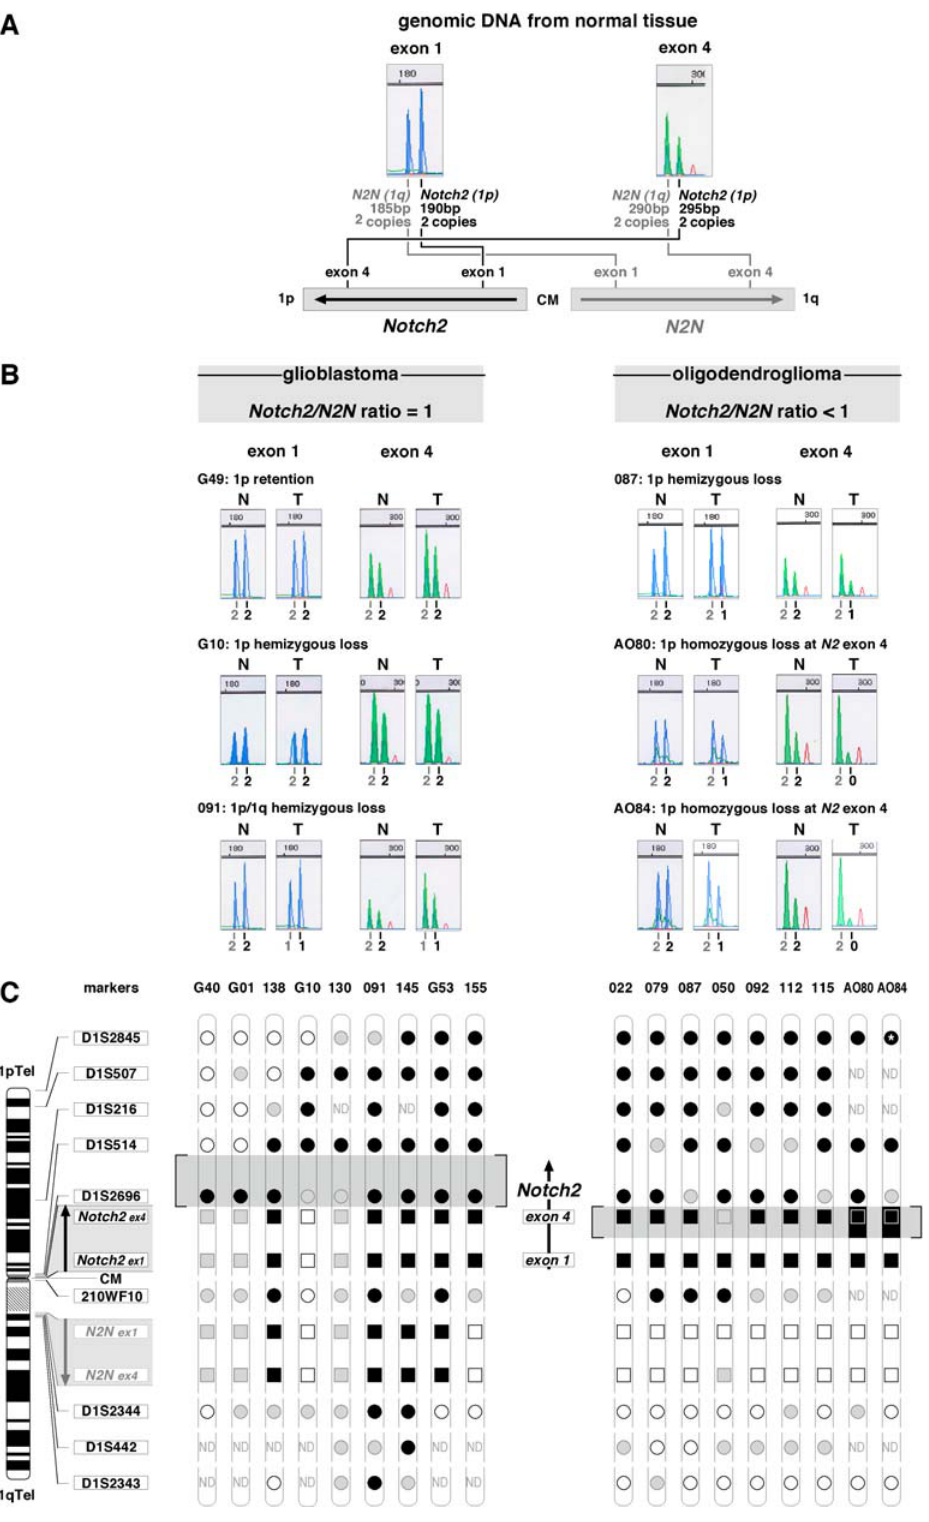
Figure 3. Refined somatic 1p deletion mapping in OD and GBM converge totheNOTCH2gene. (A) Schematic drawingof thechromosome 1 pericentric duplication and principle of the PCR-based N2/N2N test. NOTCH2 markers are in black and N2N markers are in grey. (B) The N2/N2N test distinguishes GBM (left) from OD (right). Electrophoretograms of GBM with (G10 and 091) or without (G49) 1p loss always show N2/N2N balance while OD have reduced NOTCH2 copy number relative to N2N . In GBM, NOTCH2 and N2N copy numbers indicated underneath are deduced from allelic retention (G10) or loss (091) at marker 210WF10.AO80and AO84 are tworecentOD with 1p/19qloss not included in the initial statistics.(C) Refined somatic deletion mapping deduced from the N2/N2N test. Chromosomal positions of markers and pericentric duplication are shown on the left. In GBM, minimally lost area is distally delimited by marker D1S514 (GBM G40 and G01) and proximally by NOTCH2 exon 4 (GBM G10). In OD, the minimal centromeric boundary of 1p loss is given by NOTCH2 exon 1 (all OD), while 2 homozygous losses target Notch2 exon 4 (OD AO80 and AO84). Conventional LOH data are shown by circles, datafrom the N2/N2N test are shown by squares. White: retention of both alleles; black: loss of heterozygosity; black on a black background: homozygous loss; grey: non informative. Areas of minimal allelic loss, highlighted in grey, are aligned with the targeted gene NOTCH2 shown with its sense of transcription. doi:10.1371/journal.pone.0000576.g003 PLoS ONE |